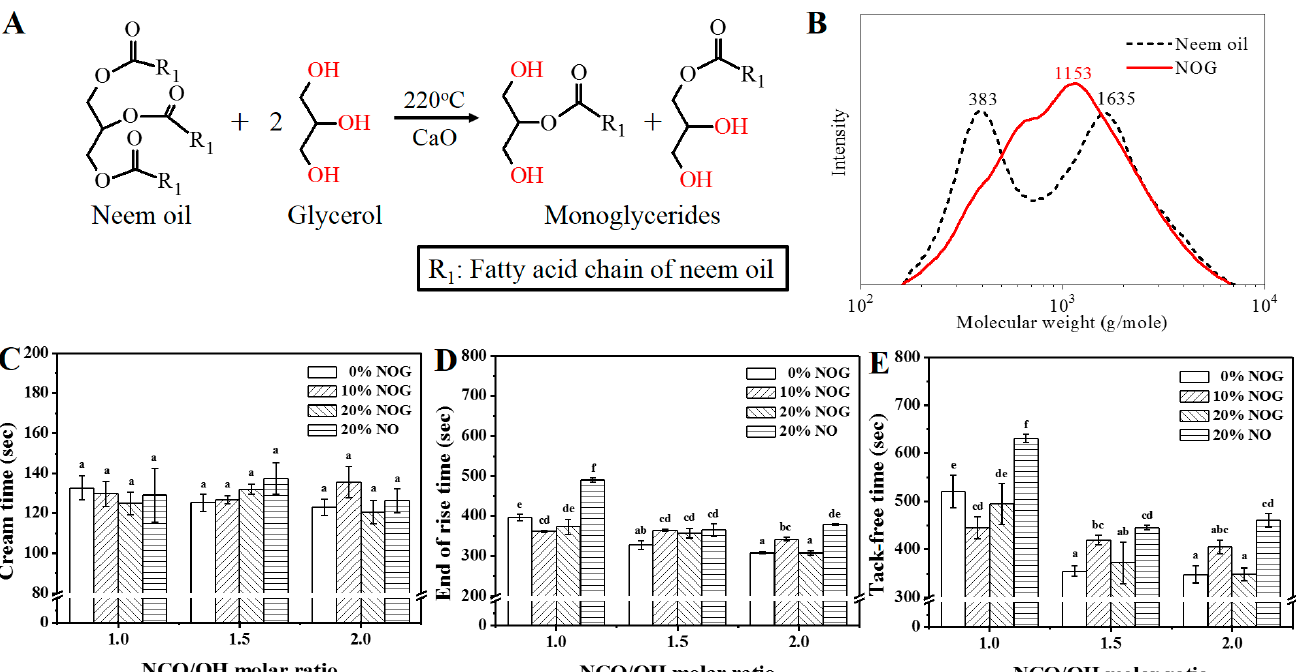
Figure 2. ( A ) General transesterification scheme of neem oil [14]. ( B ) Molecular weight distribution of neem oil and NOG. Cream time ( C ), end of rise time ( D ) and tack-free time ( E ) of PU foams. The NCO/OH molar ratios of O1-2, O2-2 and O3-2 set as 1.3, 1.9 and 2.5, respectively. The data analyzed using one-way analysis of variance (ANOVA) with Scheffe’s test, the different lowercase letters indicate statistical differences in the bar graph.